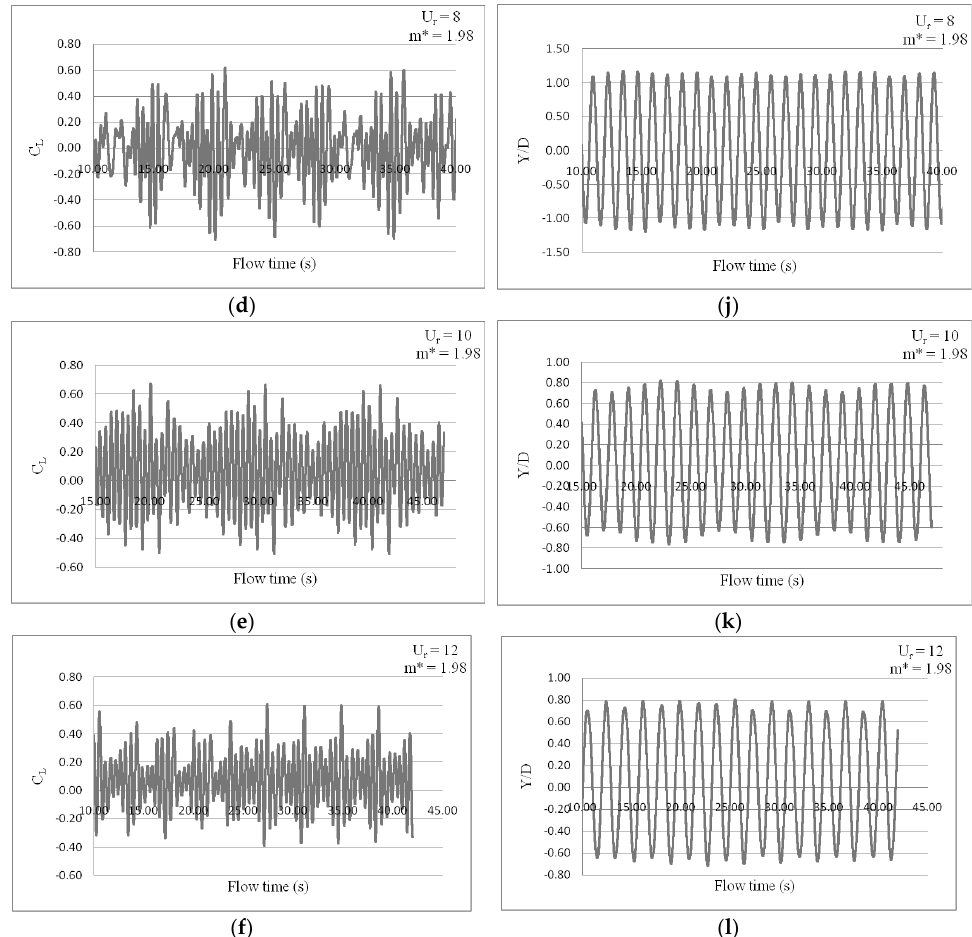
Figure 6. Time histories of hydrodynamic and structural response parameters at m* = 1.98: ( a ) C L for U r = 4; ( b ) C L for U r = 5; ( c ) C L for U r = 6; ( d ) C L for U r = 8; ( e ) C L for U r = 10; ( f ) C L for U r = 12; ( g ) Y/D for U r = 4; ( h ) Y/D for U r = 5; ( i ) Y/D for U r = 6; ( j ) Y/D for U r = 8; ( k ) Y/D for U r = 10; ( l ) Y/D for U r = 12.